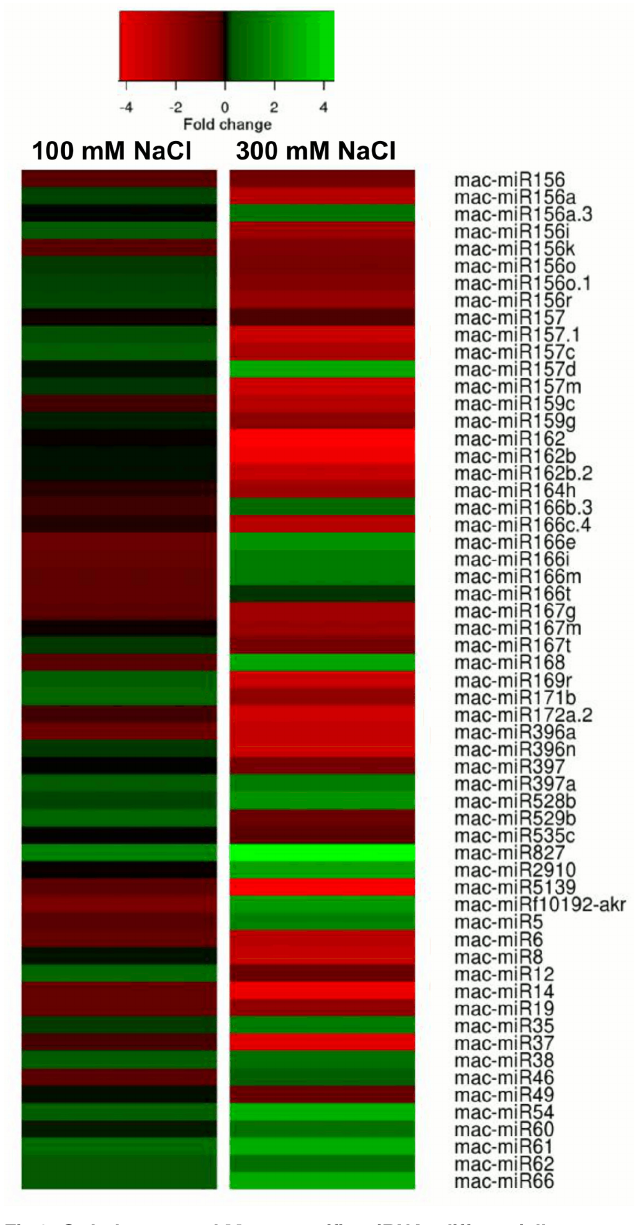
Fig 3. Orthologous and Musa -specific miRNAs differentially expressed in 100 mM and 300 mM NaCl. Statistically significant (absolute log 2 fold change (cid:1) 1 and FDR cut-off < 0.05) changes in miRNA expression in banana roots treated with 100 mM and 300 mM in comparison to untreated control (0 mM